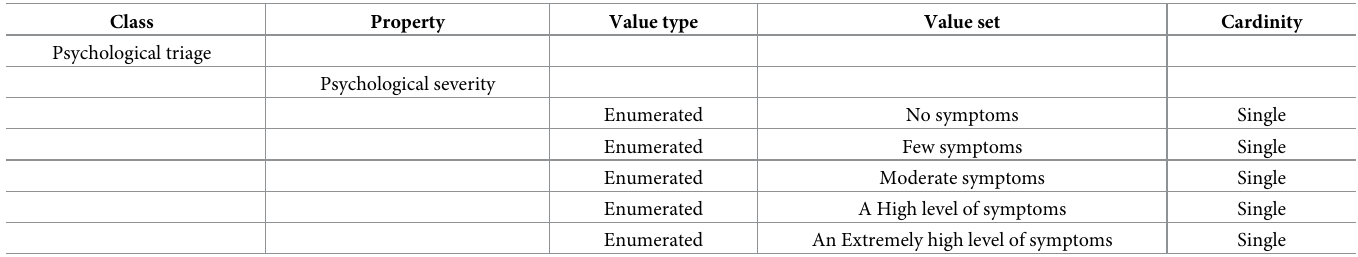
Table 3. Attribute